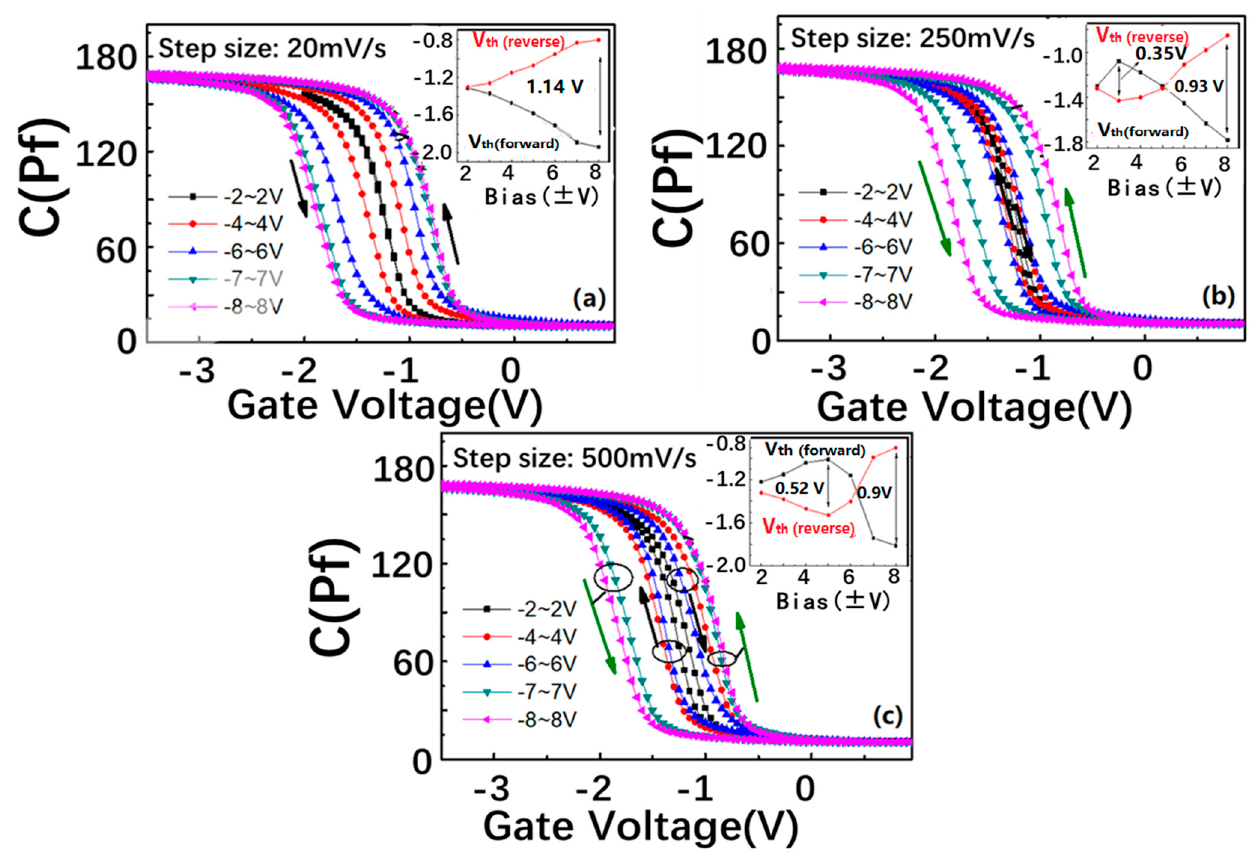
Figure 2. Double C–V sweeps of the SiN x /nc-Si(a-Si)/SiO 2 floating-gate MOS structure in different scanning bias ranges. The step sizes are ( a ) 20 mV/s, ( b ) 250 mV/s, and ( c ) 500 mV/s, respectively. The insets show the scanning bias-dependent V fb under different step sizes.